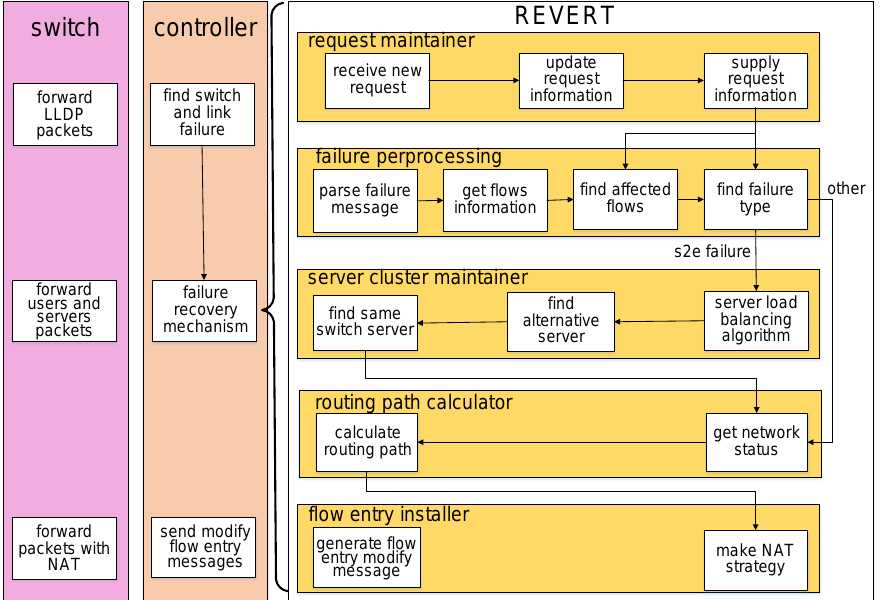
Figure 3. Overall architecture of